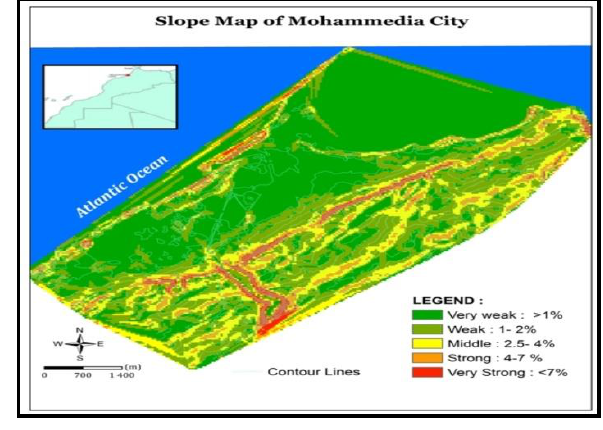
Figure 2. Slopes Map of the study area